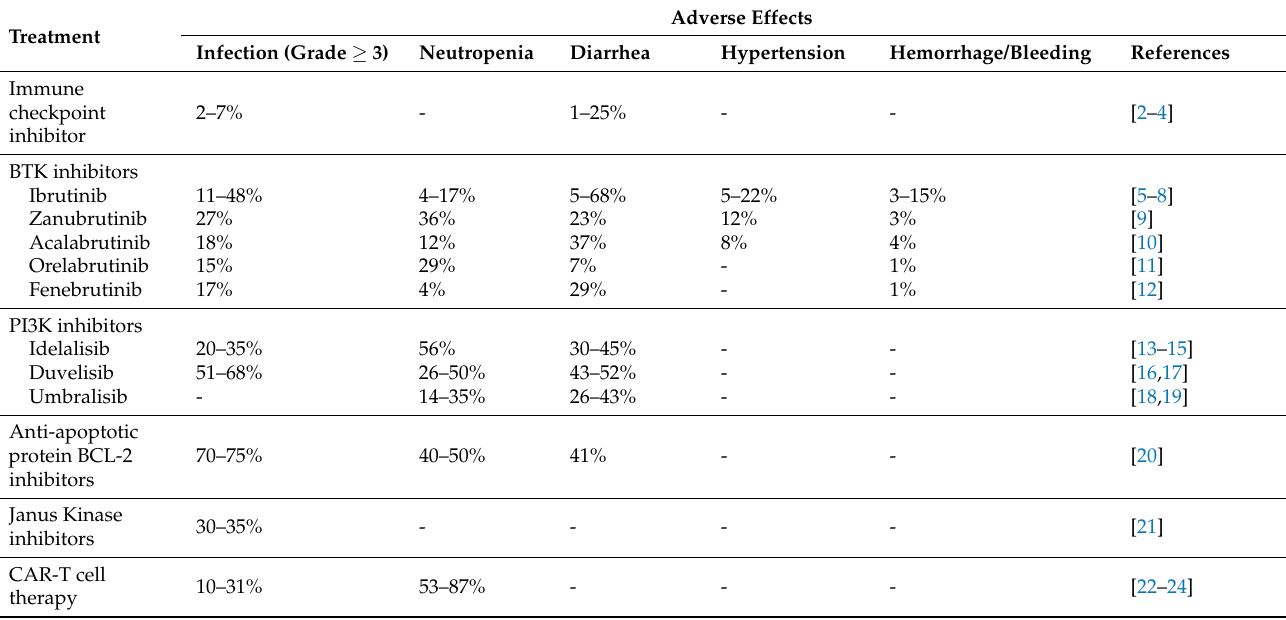
Table 1. Adverse effects and frequencies of new targeted therapies.